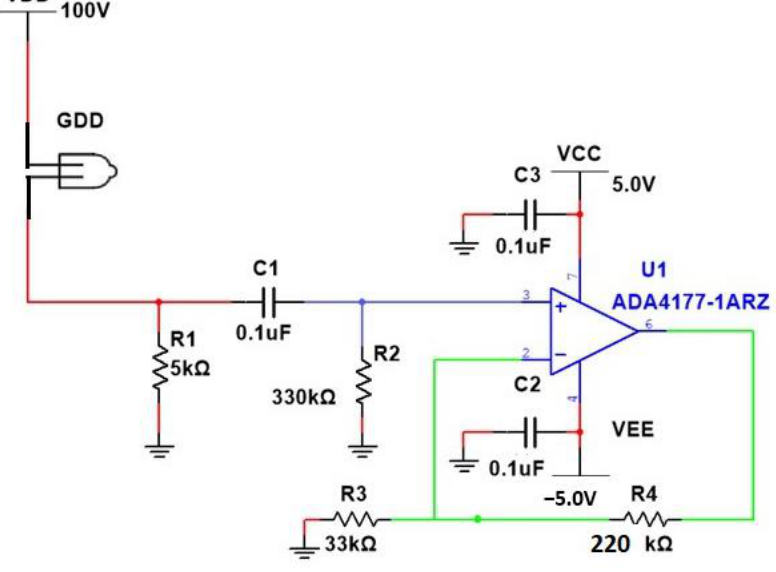
Figure 2. Detection circuit for a single GDD detector.